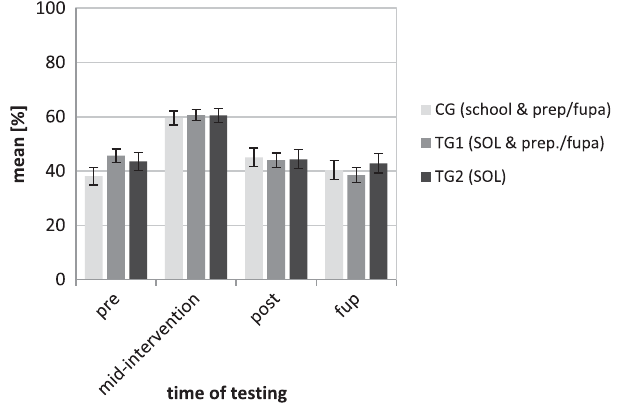
FIG. 9. Descriptive data of the subscale interest with standard error of the mean.